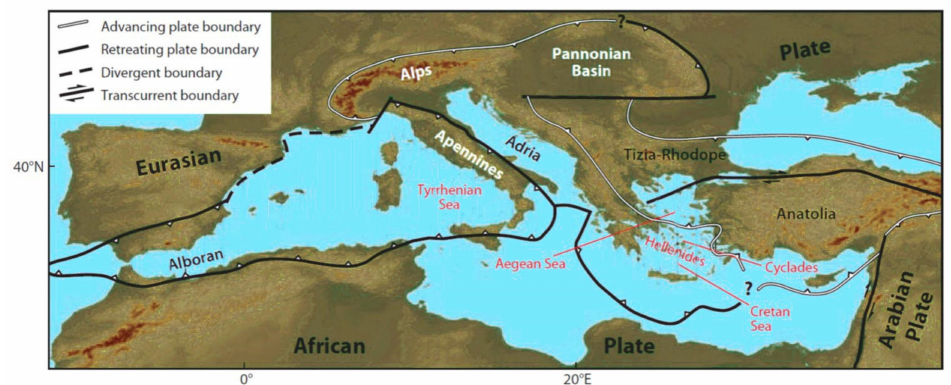
Figure 2. Simplified tectonic map of the Mediterranean plate-boundary zone showing the three major plates (Eurasian, African, and Arabian) shown, and the microplates between them. The Hellenides, the Aegean and Cretan Seas, and the Cyclades are shown